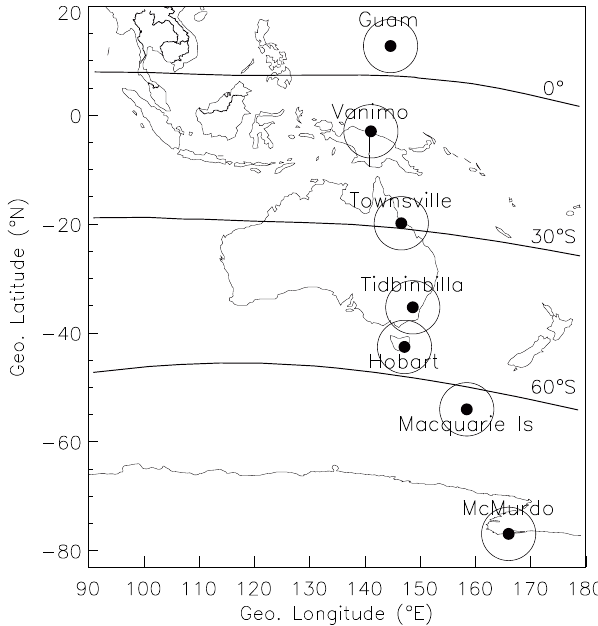
Fig. 1. Geographic maps and field of view (20 ◦ elevation) of the seven GPS receiver stations that provided data for this study. Only the receiver located at Guam evaluates the TEC at latitudes north of magnetic equator. The three horizontal curves depict the geomag- netic latitude axis at 0 ◦ , 30 ◦ S, and 60 ◦ S, respectively, from top to bottom.